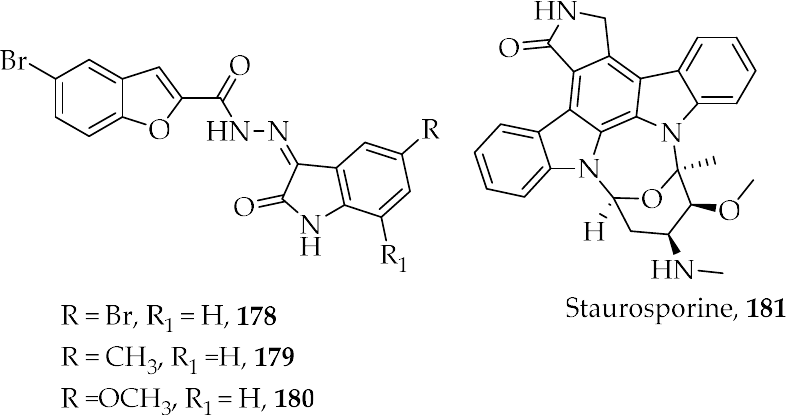
Figure 46. Structures of oxindole-benzofuran hybrids 162 – 164 and the bis-indole Staurosporine with a summary of their biological activity towards selected cancer targets.